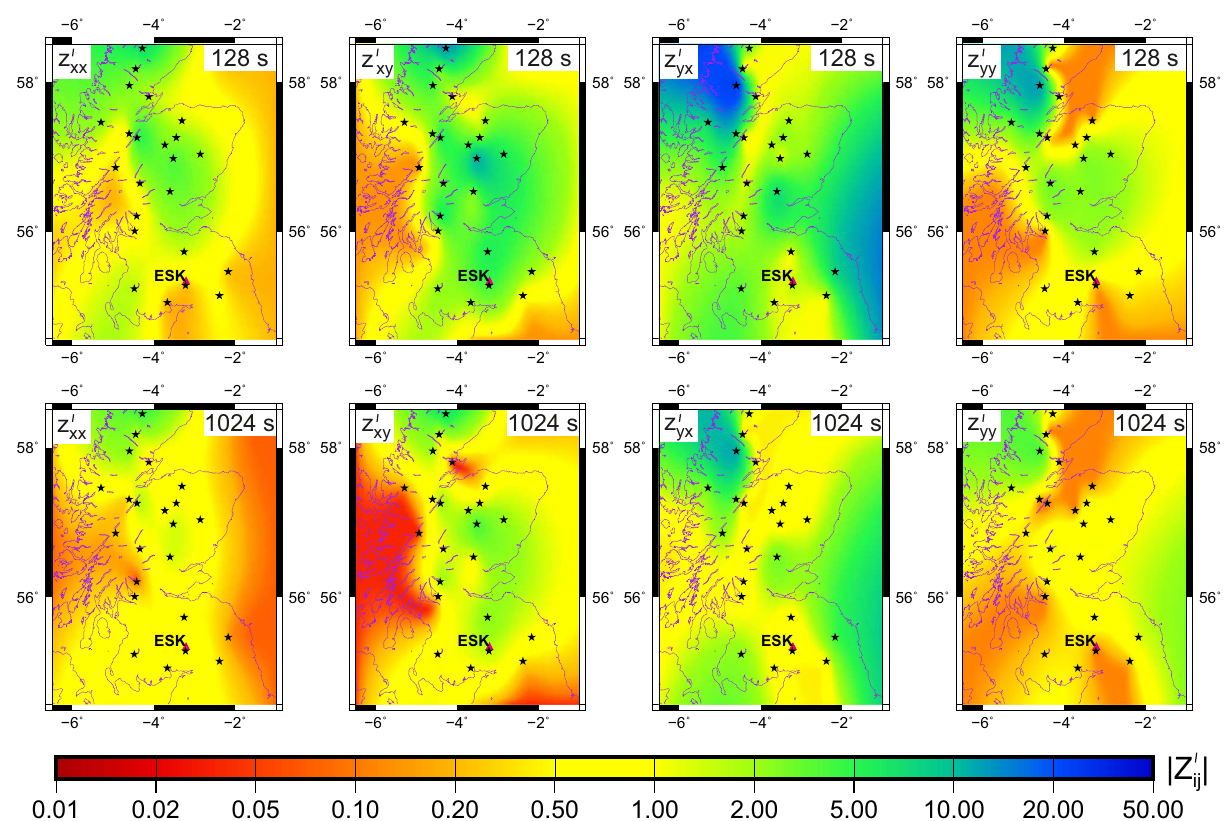
Fig. 4. Modi fi ed impedance tensor components, Z 0 , following perturbation-tensor correction, at periods of 128 s and 1024 s interpolated using ij bicubic splines (Smith & Wessel, 1990). Stars indicate site